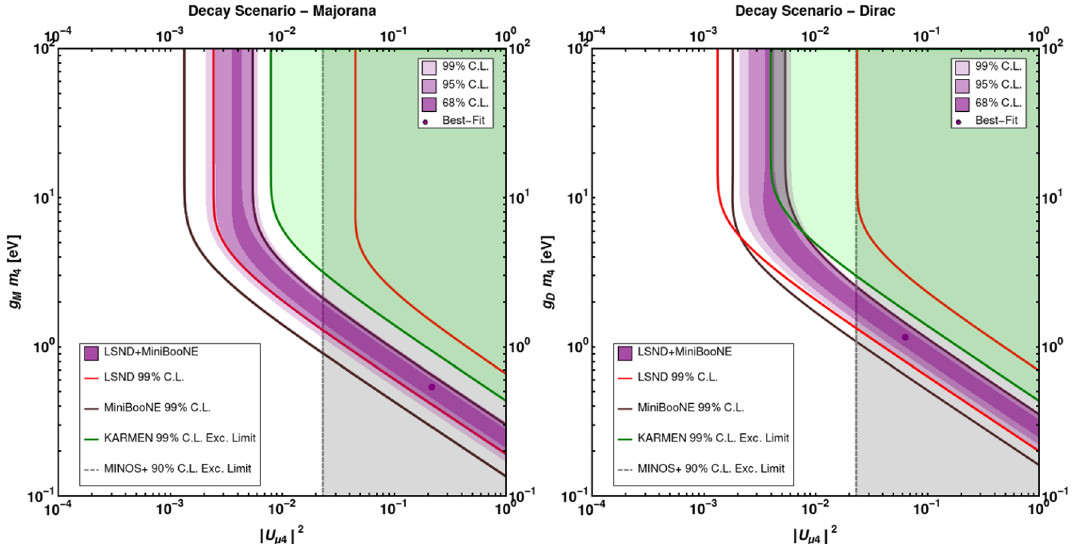
Figure 7 . Allowed regions at 99% (lighter purple), 95% (medium purple) and 68% (darker purple) C.L. of the ( j U (cid:22) 4 j 2 ; gm 4 ) parameter space when the decaying-sterile-neutrino hypothesis is matched against the combined LSND data and MiniBooNE neutrino-mode and antineutrino-mode data assuming Majorana (left) or Dirac neutrinos (right). The dots indicate the best-(cid:12)t-point. The region to the right of the vertical line is excluded by MINOS+ at the 90% C.L. [40]. The green shaded region on the top-right of the green line is excluded by KARMEN at the 99% C.L.